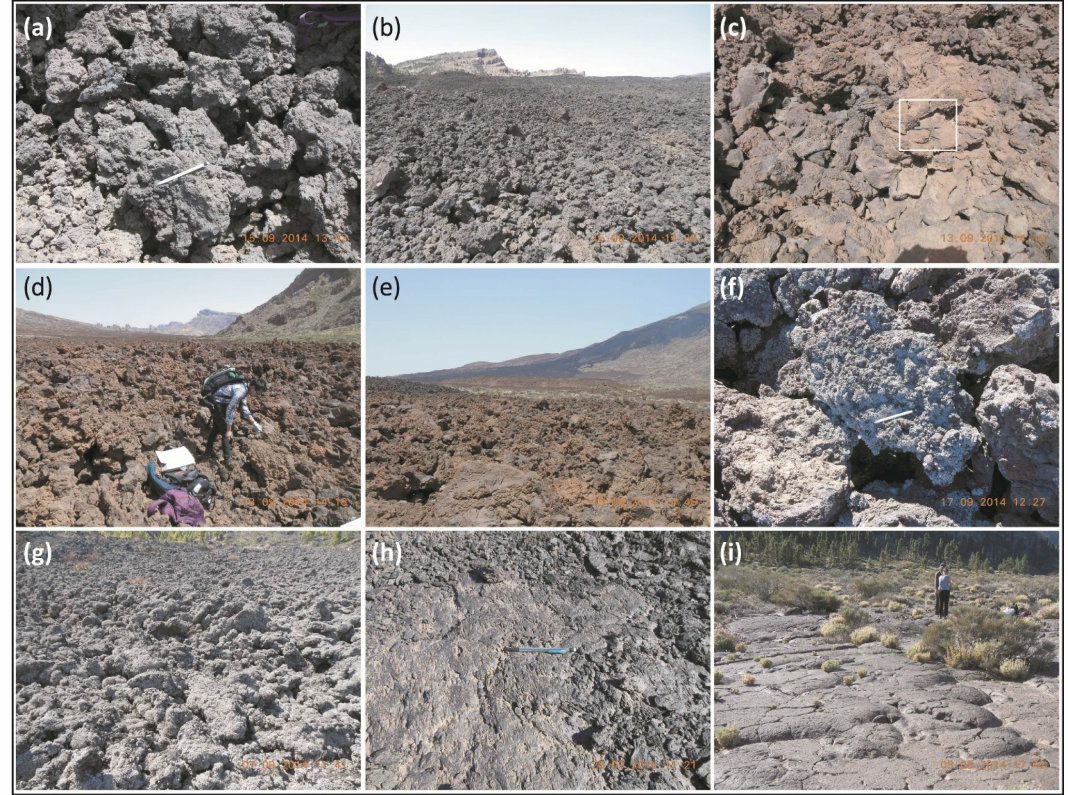
Figure 3. Illustration of different lava surfaces on Tenerife: ( a ) fresh ‘a‘¯a lavas on the Chahorra flow at site C05; ( b ) a large view of the Chahorra lava flow at site C07; ( c ) undated oxidized ‘a‘¯a lavas in caldera at site U10; ( d ) a large view of the undated surface at site U10; ( e ) comparison between the Chahorra lava (dark color in the background) and the undated lava (foreground); ( f ) partly oxidized ‘a‘¯a lavas with few lichens on Chinyero at site Y07; ( g ) lichen-covered ‘a‘¯a lavas on Garachico at site G06; ( h ) patch of fresh p¯ahoehoe lavas on Chahorra at site C03P; and ( i ) undated oxidized p¯ahoehoe lavas in caldera at site U06P. A 15 cm long pencil in ( a ), ( c ), ( f ) and ( h ) and humans in ( d ) and ( i ) are placed for visual comparison of